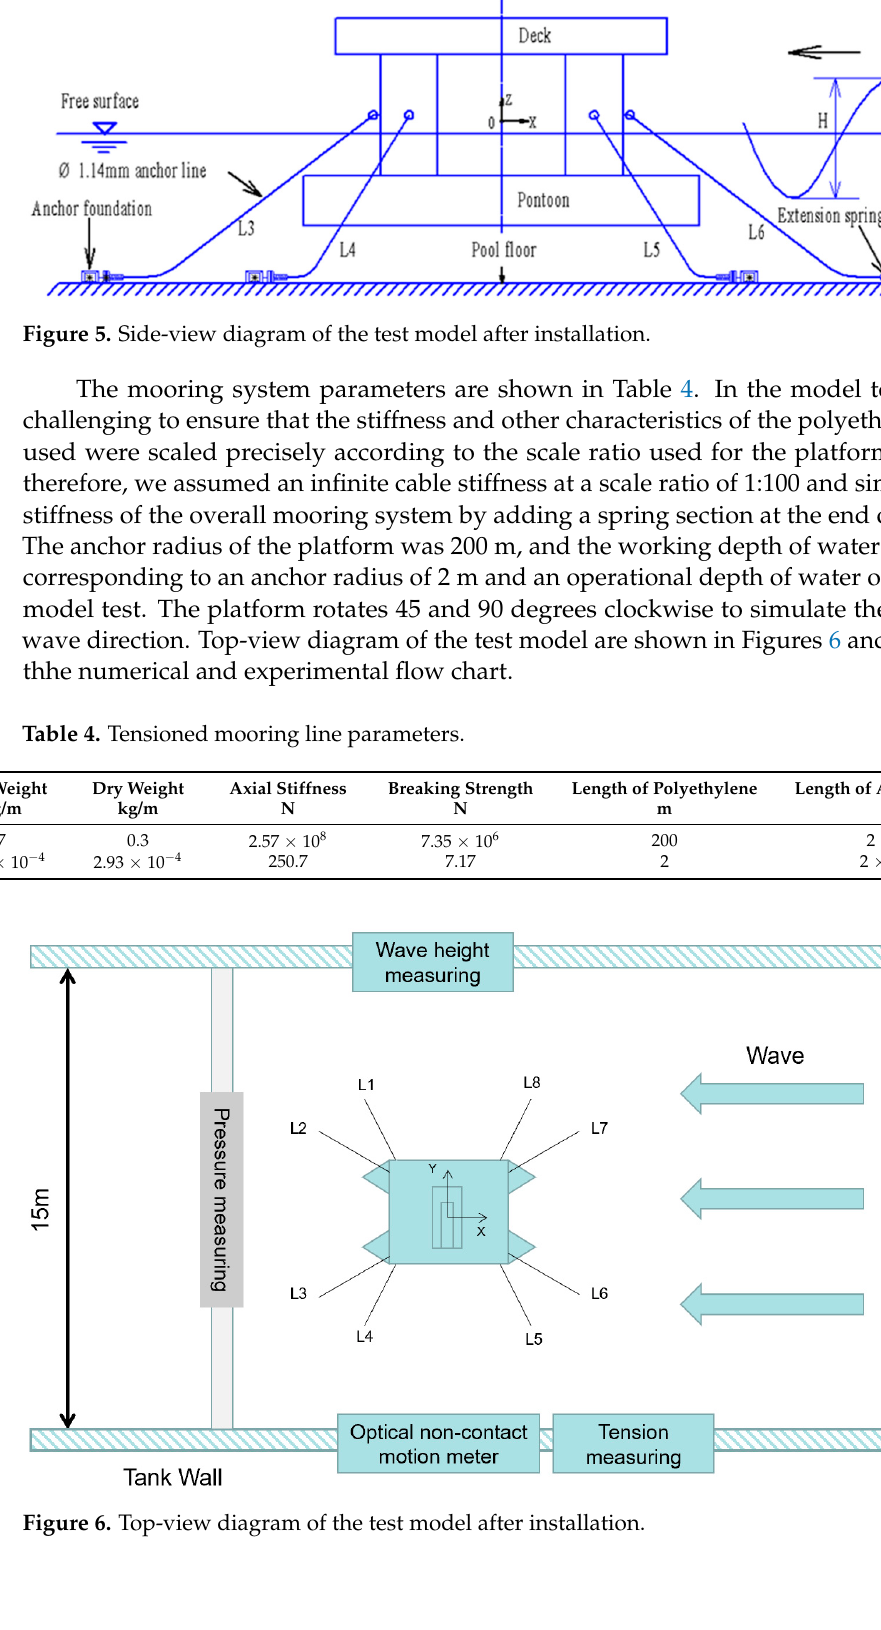
Figure 7. The numerical and experimental flow chart.